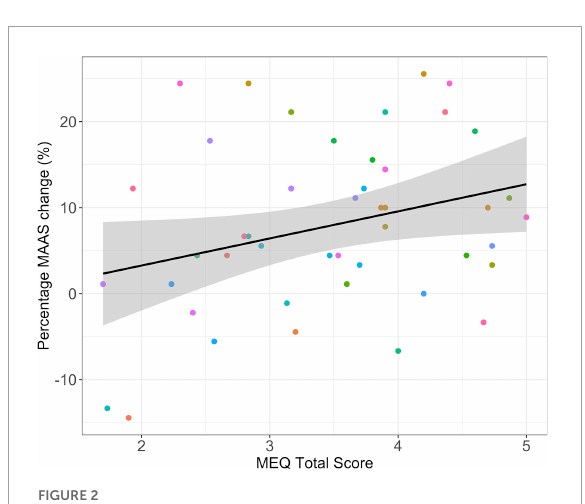
FIGURE2 Mystical Experience Questionnaire (MEQ) total score association with percentage change in Mindful Attention and Awareness Scale (MAAS). Black line and gray shading: Estimated regression line and 95% confidence interval. Colored circles: Individual participants. No participants had an MEQ score ≤ 1.